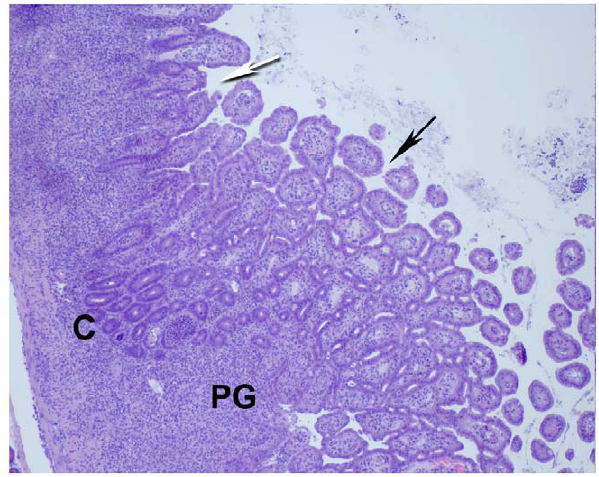
Figure 2. Pyogranulomatous inflammation of the mesenteric lymph node. Cross section showing confluent pyogranulomatous inflammation (PG) with caseous necrotic centers (arrows) (shown at at 4X magnification). Details of processing and staining of the tissue are provided in Materials and Methods.